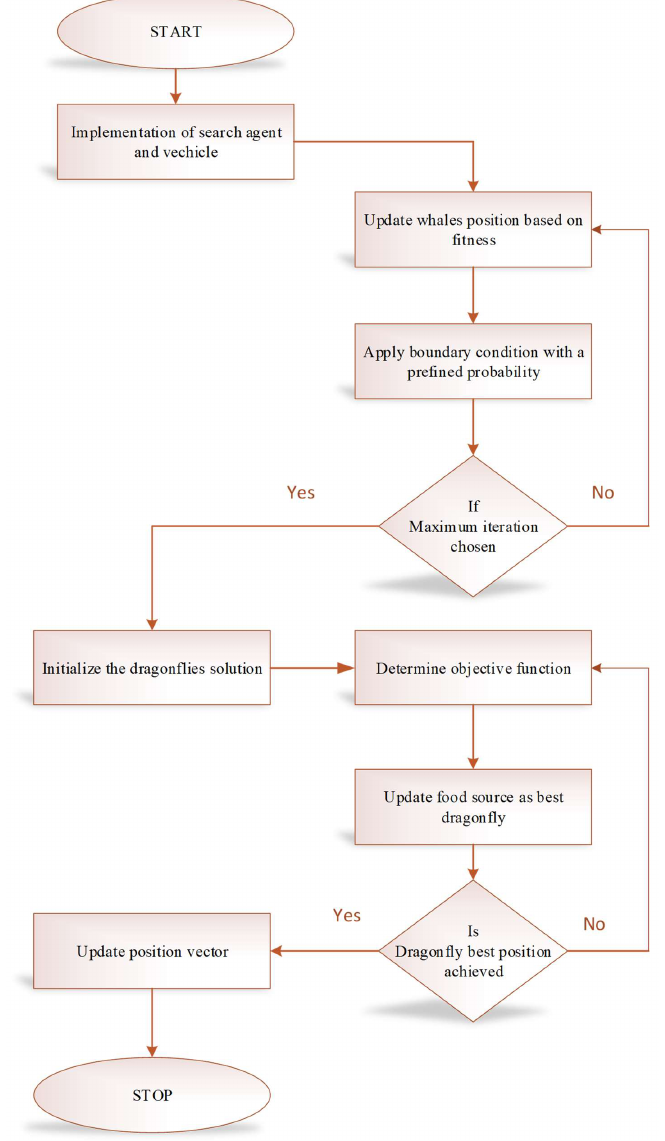
Figure 7. Flowchart for H-WDFOA-VANET.